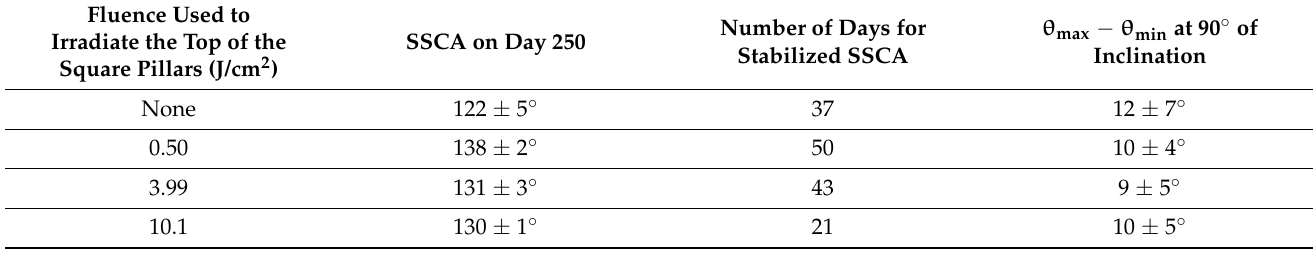
Table 1. Wetting measurement results for the samples textured in ambient